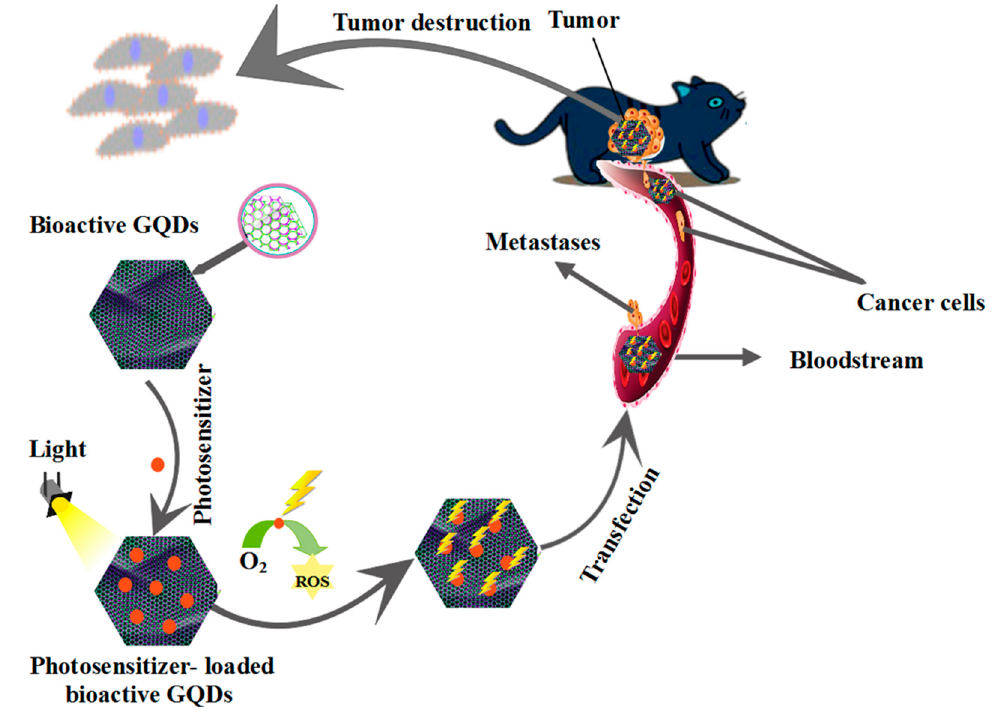
Figure 10. Tumor destruction using the photodynamic method based on bioactive GQDs.